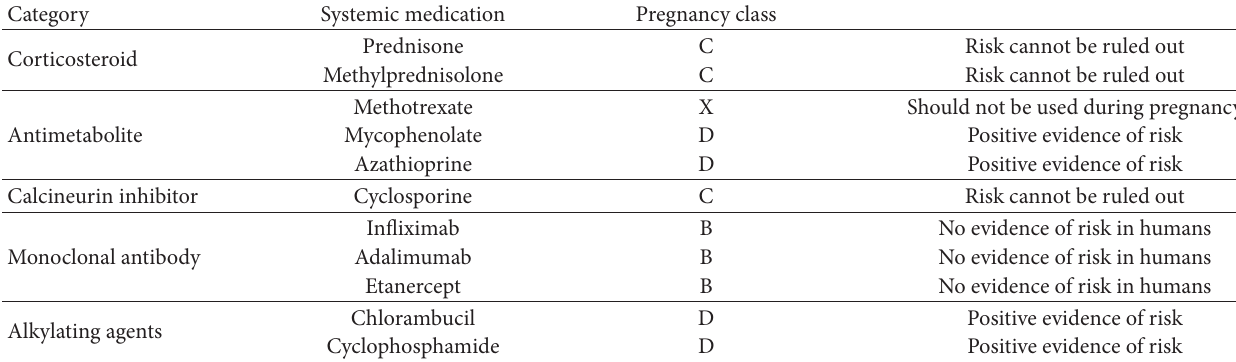
Table 1: Pregnancy classes of medications used to treat systemic